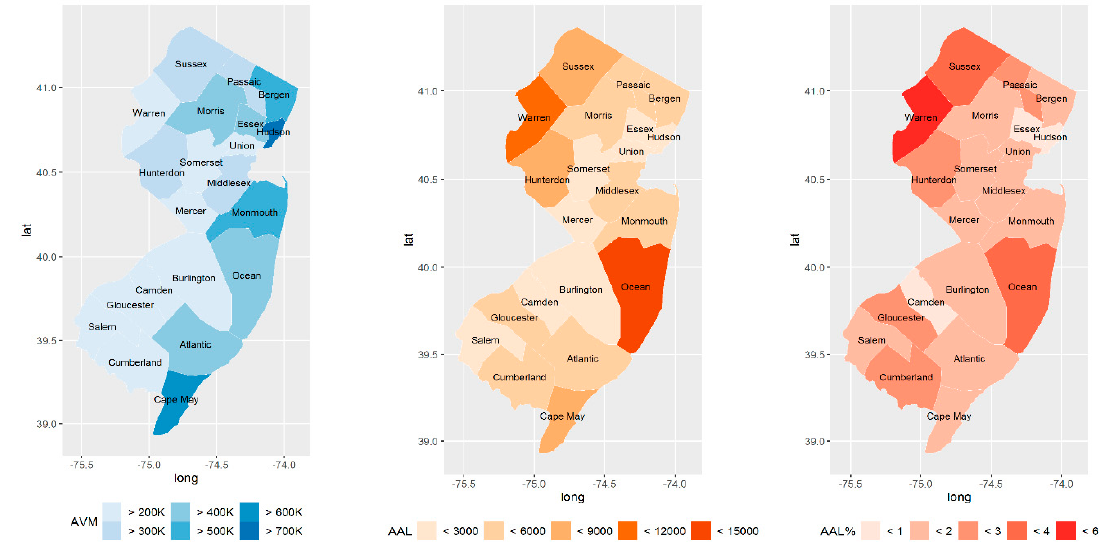
Figure 5. The spatial pattern of average property values, Average annual losses (AAL) values and the percentage of AAL across different counties in New Jersey.